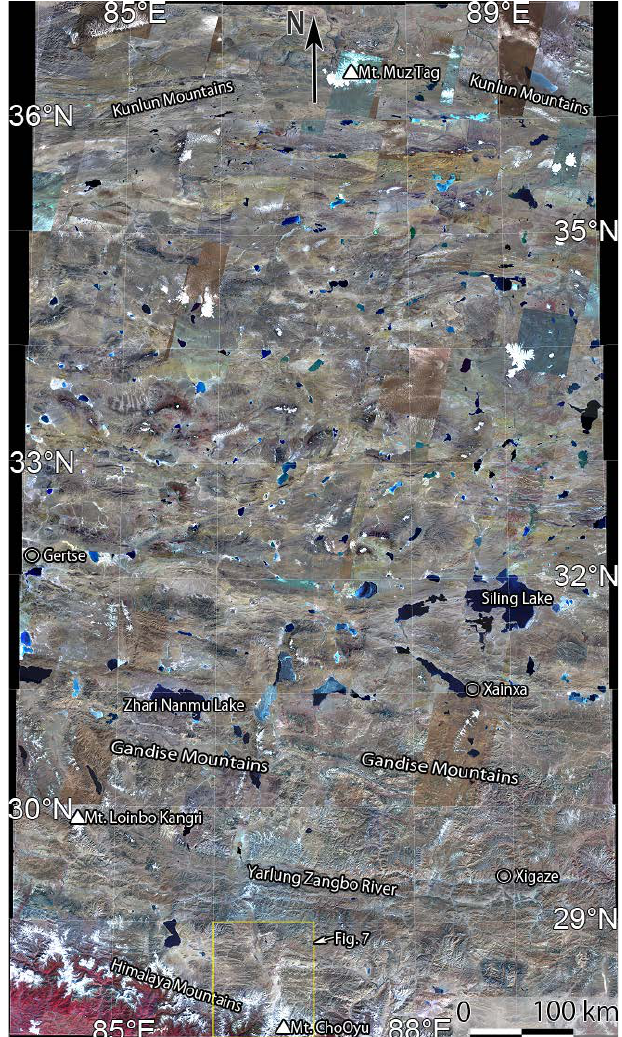
Figure 2. Mosaic VNIR false color image generated with the ASTER data used in this study, assigned as blue for band 1, green for band 2 and red for band 3 covering the study area bounded by latitude 28 ◦ N to 37 ◦ N and longitude 84 ◦ E to 90 ◦ E, using a Universal Transverse Mercator (UTM) map projection. Geographical locations of some cities, mountains, etc., are shown. The yellow rectangle represents the area of Figure